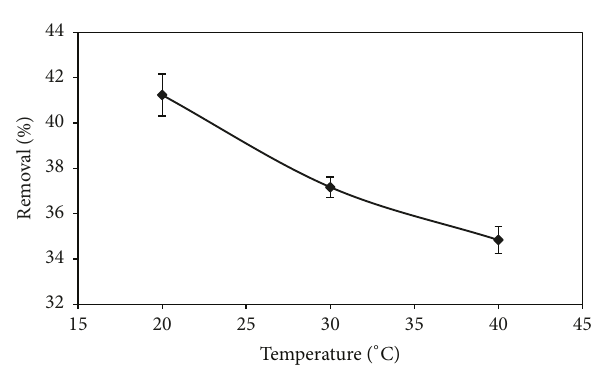
Figure 8: Effect of